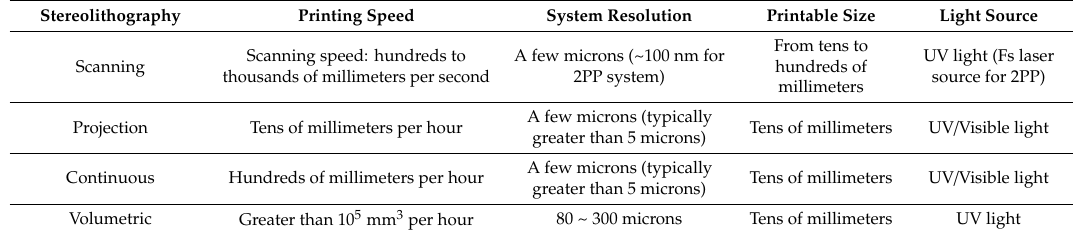
Table 2. Comparison of four generations of stereolithography